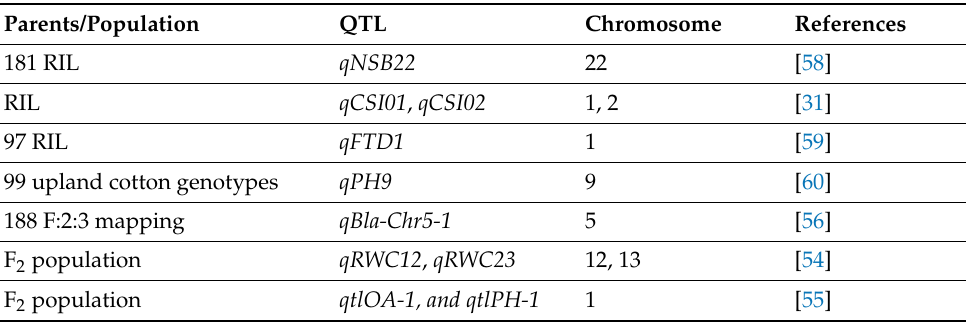
Table 1. QTL identified for drought tolerance in